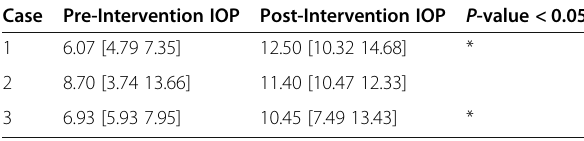
Numbers in brackets are confidence intervals of the mean pressures. All pressured reported in mmHg. P value corresponds to the difference between pre-intervention and post-intervention mean